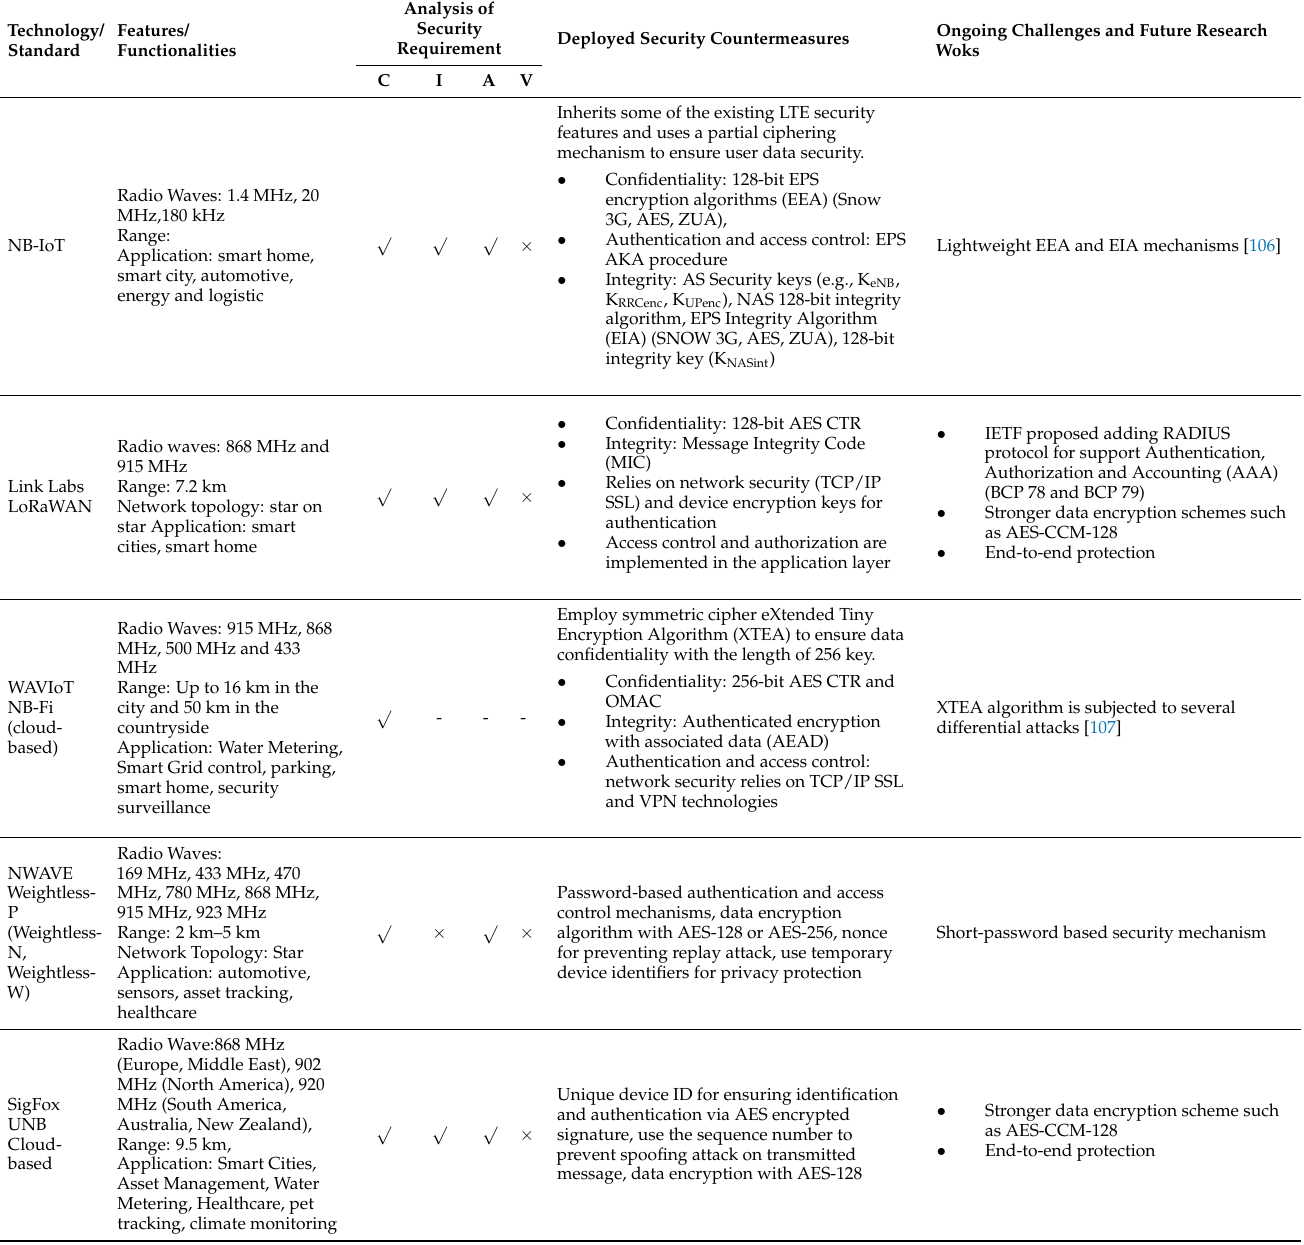
Table 9. Security analysis on backbone network and communication